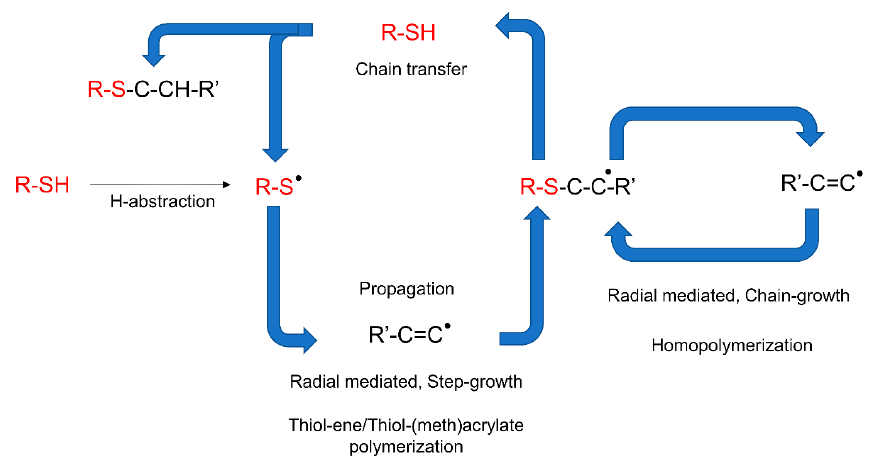
Figure 24. Reaction cycle representing mixed-mode thiol-ene and acrylate homopolymerization. Active carbon centers can participate in chain transfer as well as chain propagation. Reproduced with permission from [225]. Copyright © 2022 John Wiley and Sons.